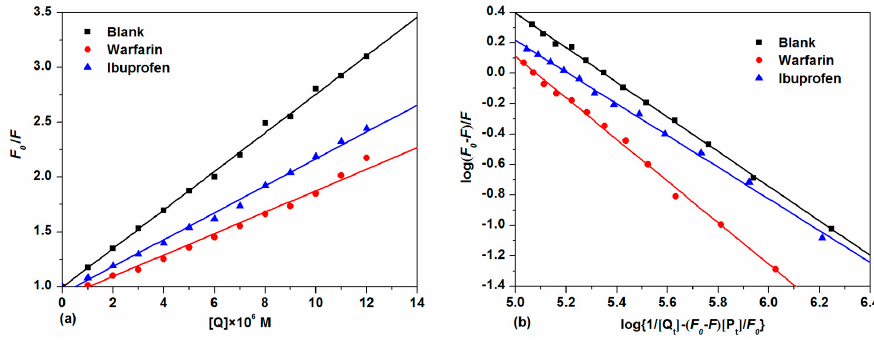
Figure 9. Plots of F 0 / F vs. [Q] ( a ) and log( F 0 − F )/ F vs. log{1/[Q t ] − ( F 0 − F )[P t ]/ F 0 }; ( b ) for competitive experiments of TCPC and HSA-site marker systems.